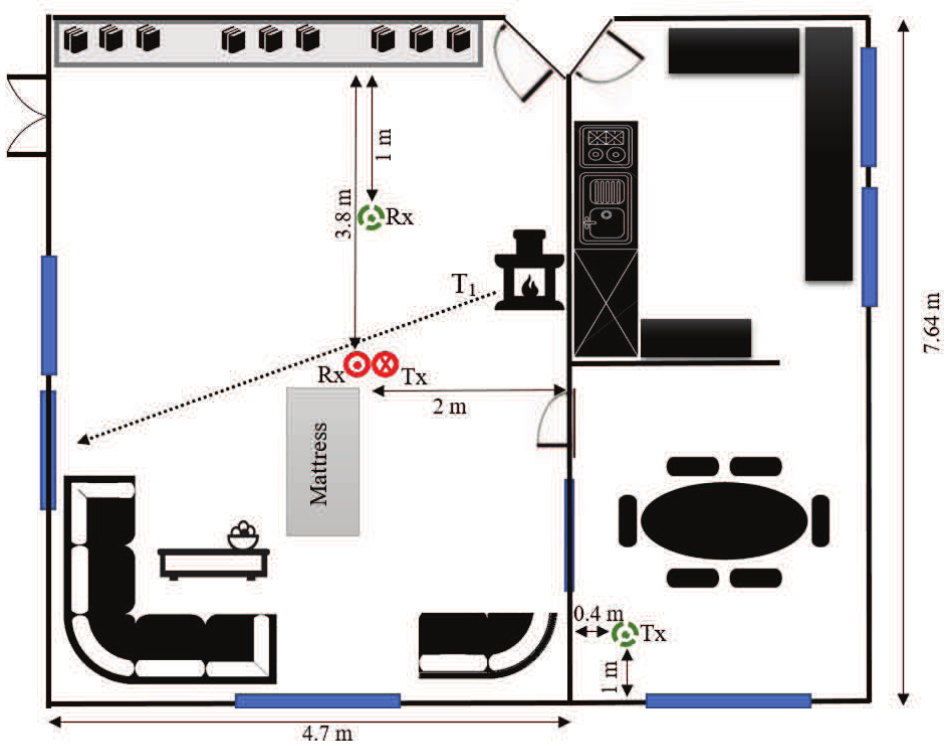
Figure 2. A schematic presentation of the propagation environment, illustrating Trajectory T 1 of the user, as well as the LOS (red solid-line circles) and OLOS (green dashed-line circles) position of the Tx/Rx antennas.